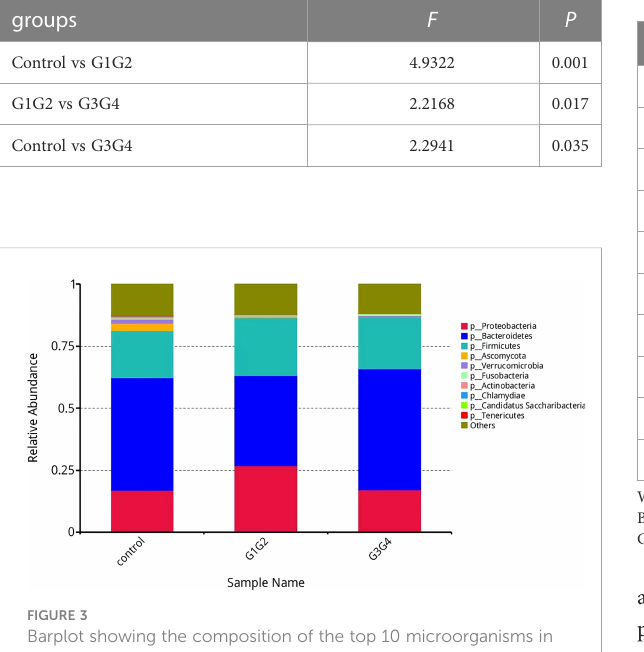
FIGURE 3 Barplot showing the composition of the top 10 microorganisms in terms of maximum relative abundance at the phylum